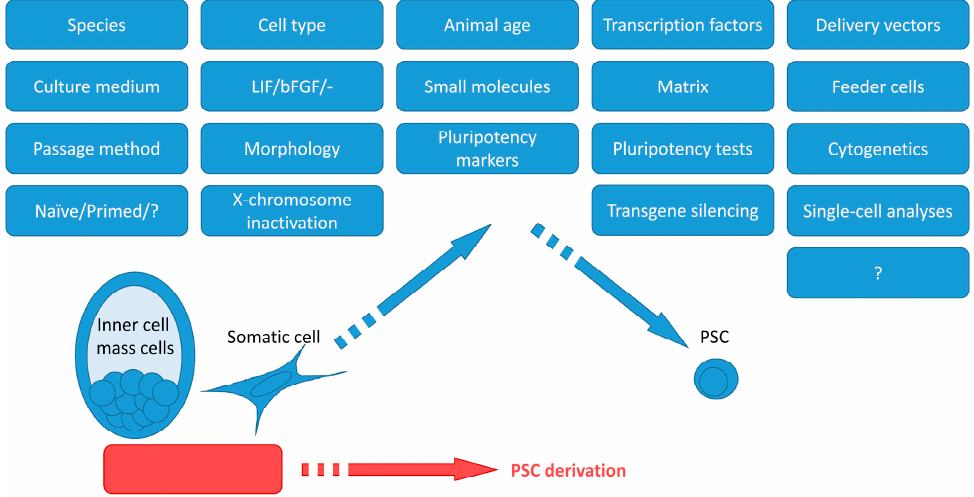
Figure 1. Important factors for the derivation, maintenance, and analysis of